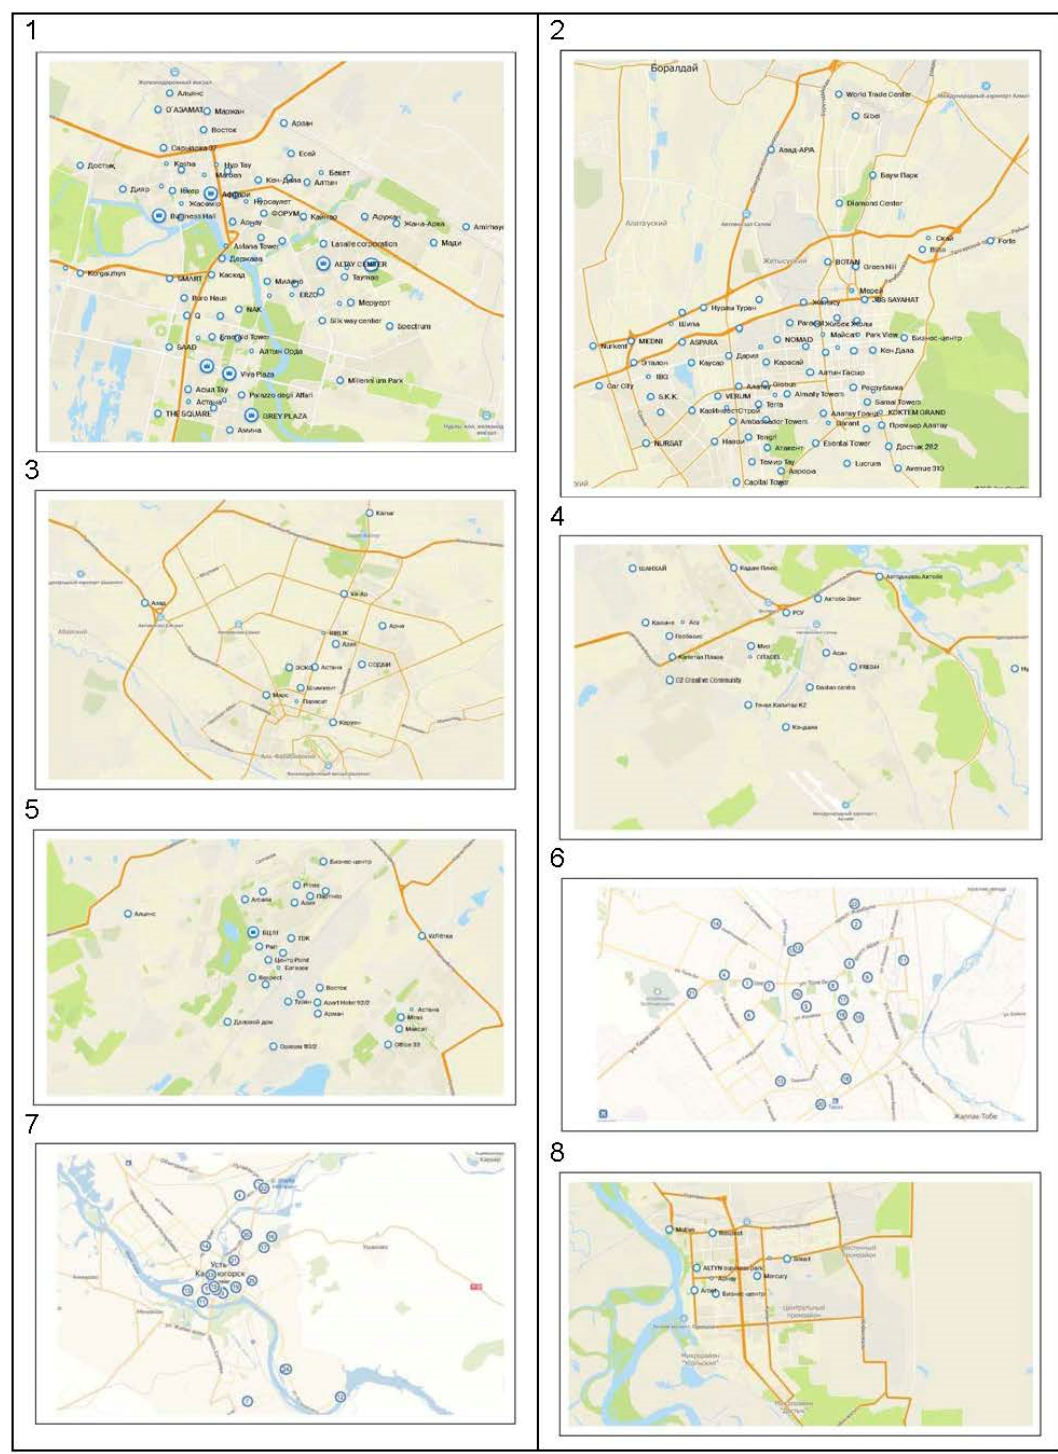
Figure 4. The locations of the main business centers in the city structure: ( 1 ) Astana [75]; ( 2 ) Almaty [76]; ( 3 ) Shymkent [77]; ( 4 ) Aktobe [78]; ( 5 ) Karaganda [79]; ( 6 ) Taraz [80]; ( 7 ) Ust-Kamenogorsk [81]; and ( 8 ) Pavlodar [82].